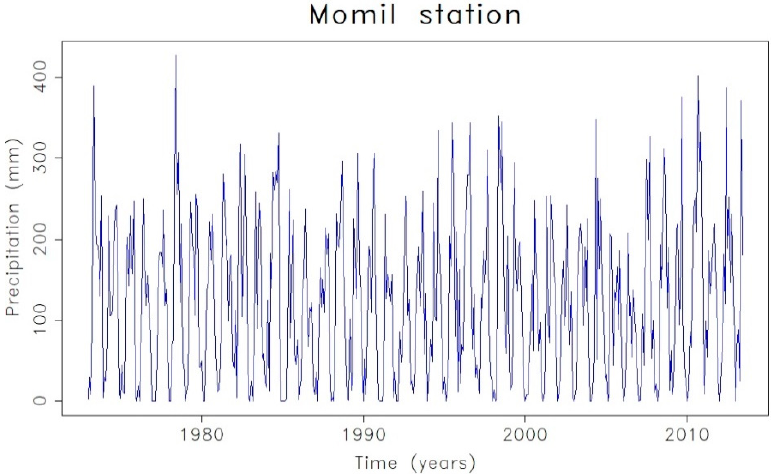
Figure 3. Calibration vector of the monthly precipitation time